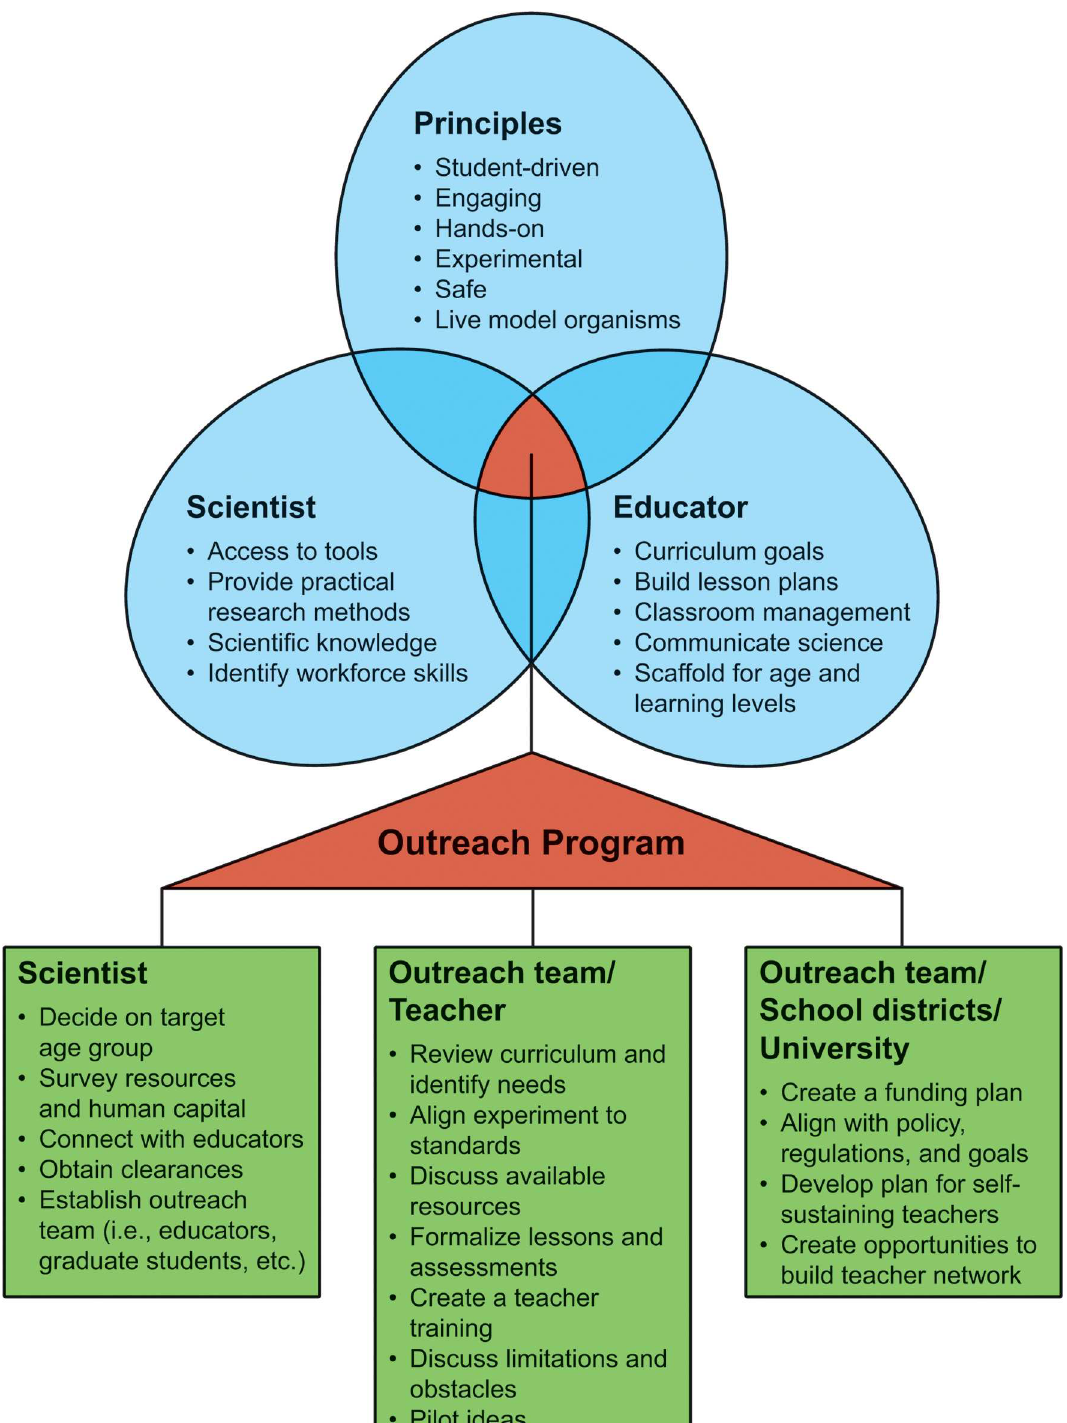
Fig 2. Proven principles for creating a successful science outreach program. BioEYES began working directly with teachers, pilotingthe experimentin classrooms and aligningthe experience with content requiredby local and/or national standards. We have found that buildinga relationship from the classroom up (i.e., teachers with the approval of their administrators, then multiple grades within a school, and finally a district-wide roll out) enablesthe program to prove its feasibility, curriculumalignment,and teacher enthusiasm—all requiredfor sustainability. Moreover, K–12